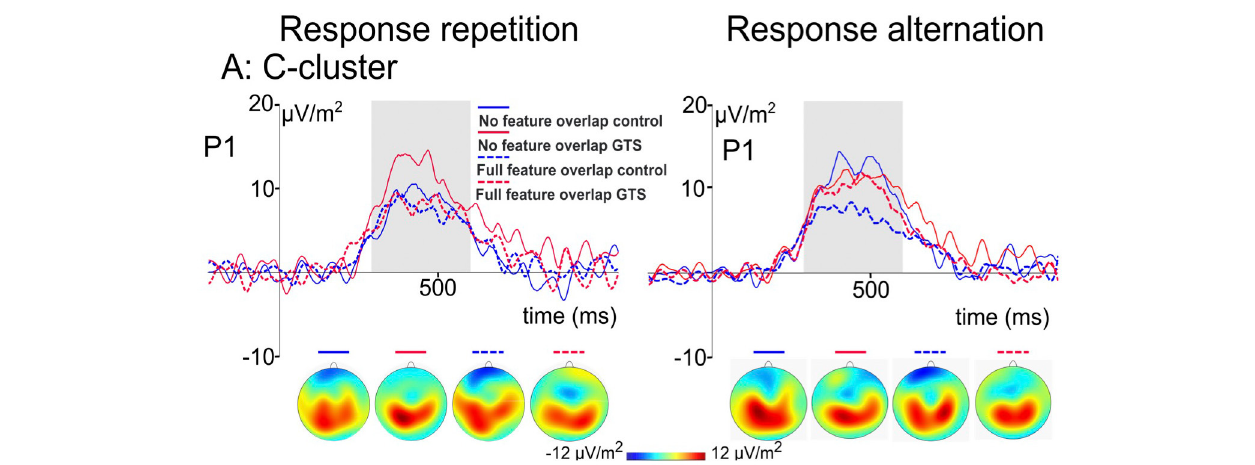
FIGURE 2 | C-cluster ERP signal of the two-step stimulus response task by Kleimaker et al. (see above) derived by means of RIDE analysis. Using response repetition condition (left side) and response alternation condition (right side) as well as stimulus features being iterated (dashed line) or altered (solid line), there are conditions exhibiting partial repetition costs (e.g., response repetition in case of stimulus features being altered) and partial repetition benefits (e.g., response alteration in case of stimulus features being altered). Corresponding c-cluster ERP signals are compared between GTS patients (red lines) and healthy controls (blue lines). The scalp topography plots show the distribution of the mean activity in the analyzed time